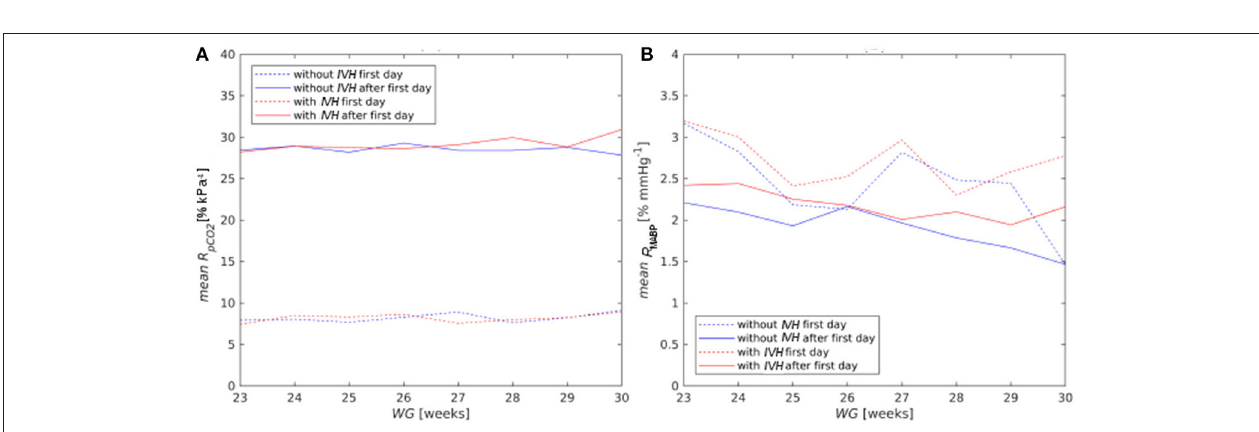
FIGURE 5 | (A) Mean CBF for the first (dashed curves) and after the first day of life (solid curves); (B) mean absolute deviation of CBF from the mean value of the control group ( CBF control ) for all postnatal days.